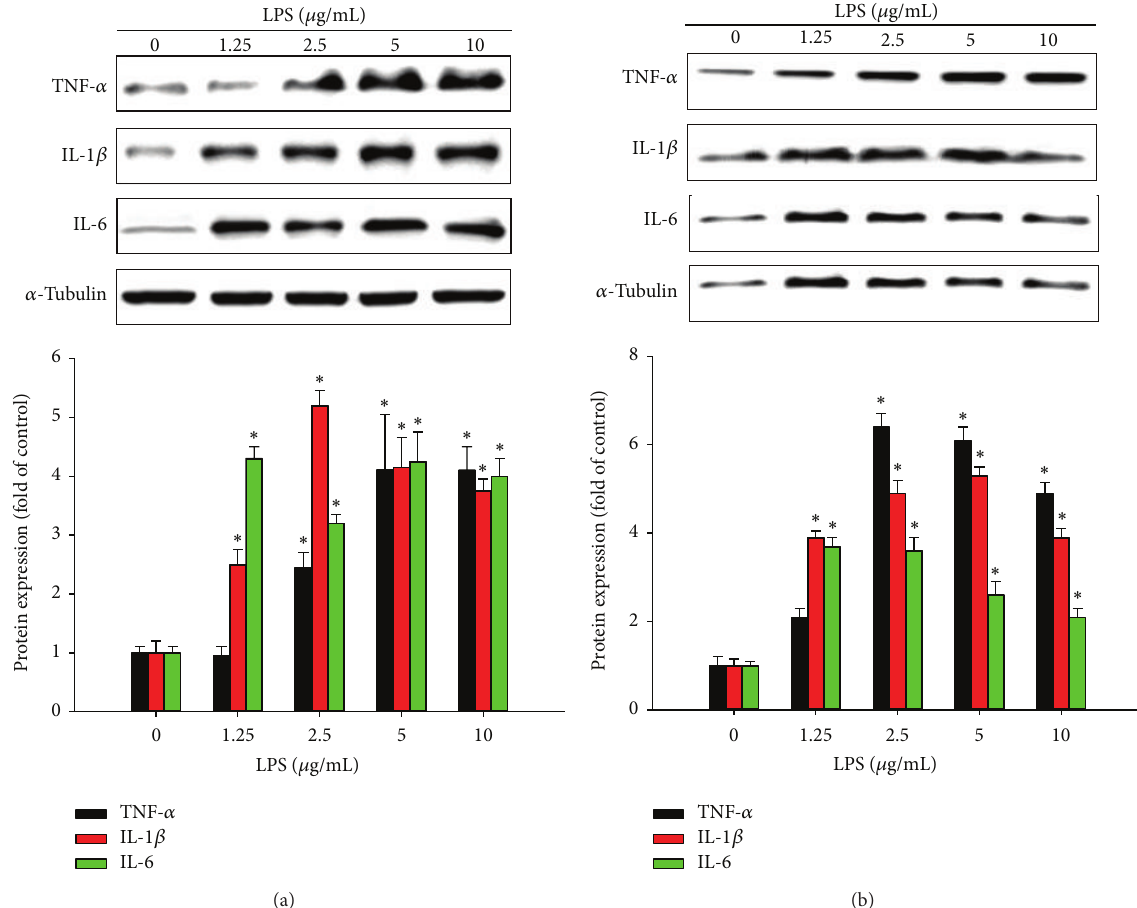
Figure 1: Effects of lipopolysaccharide (LPS) exposure on proinflammatory cytokine expression in human bronchial epithelial cells. Cells from the (a, b) HBEC and (c, d) BEAS-2B lines were incubated with various concentrations of LPS for various durations, and proinflammatory cytokine expression was evaluated using western blotting. Tumor necrosis factor- 𝛼 (TNF- 𝛼 ), interleukin- (IL-) 1 𝛽 , and IL-8 proteins expression were upregulated in a dose-dependent manner. Data are presented as means ± standard error of the mean (SEM) from 3 independentexperiments.Eachbargraphshowssummarizeddatafrom3separatedensitometryexperimentsafternormalizationto 𝛼 -tubulin (an internal control for cytoplasm protein). ∗ 𝑃 < 0.05 versus LPS dose 0 or time